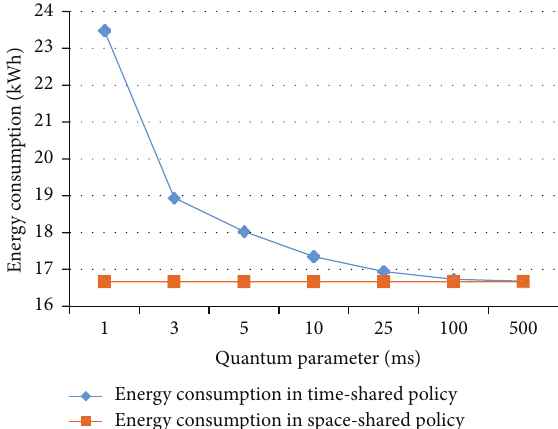
Figure 6: Turnaround time for various quantum parameters with increasing data size.